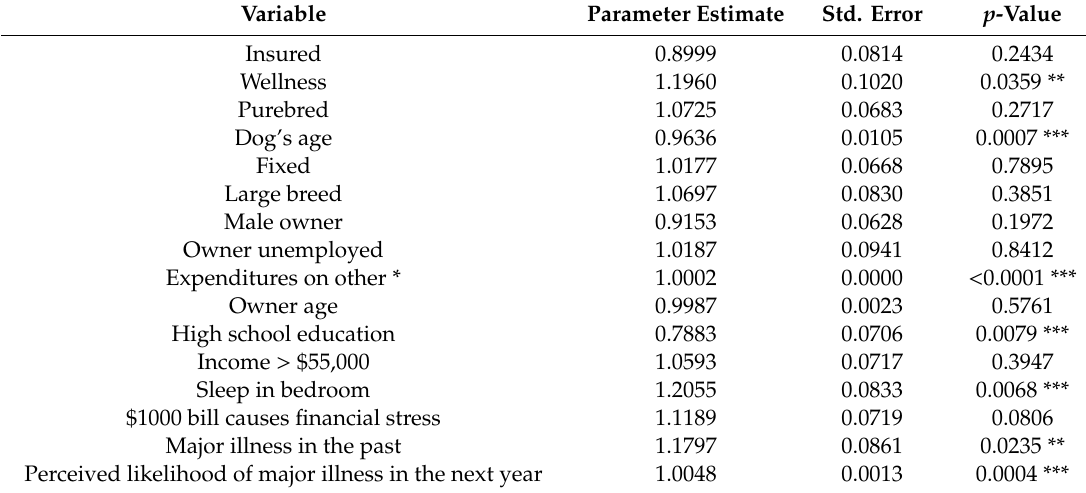
Table 5. Incidence rate ratios for negative binomial count model with number of visits as the dependent variable. Variable Parameter Estimate Std. Error p